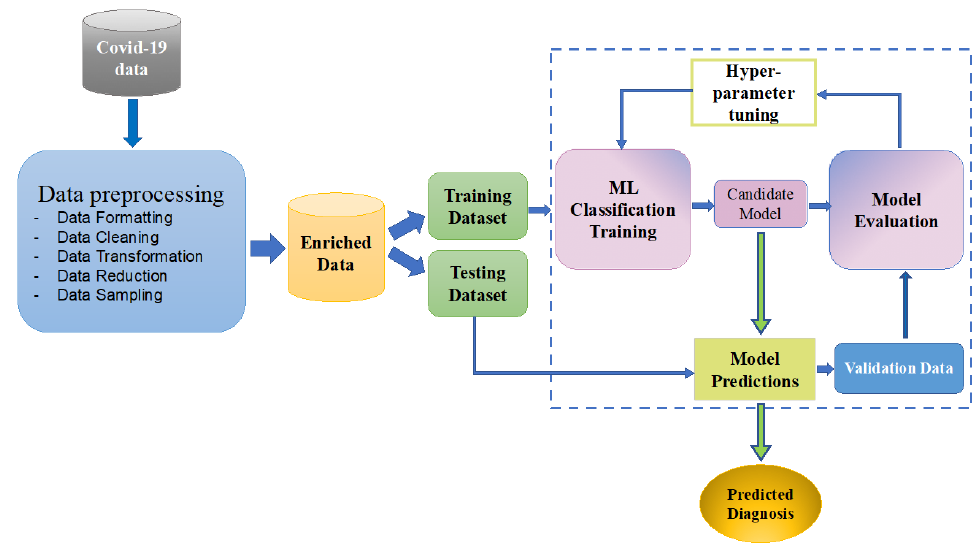
Figure 7. Work flow diagram of machine learning based framework for detecting the likelihood of